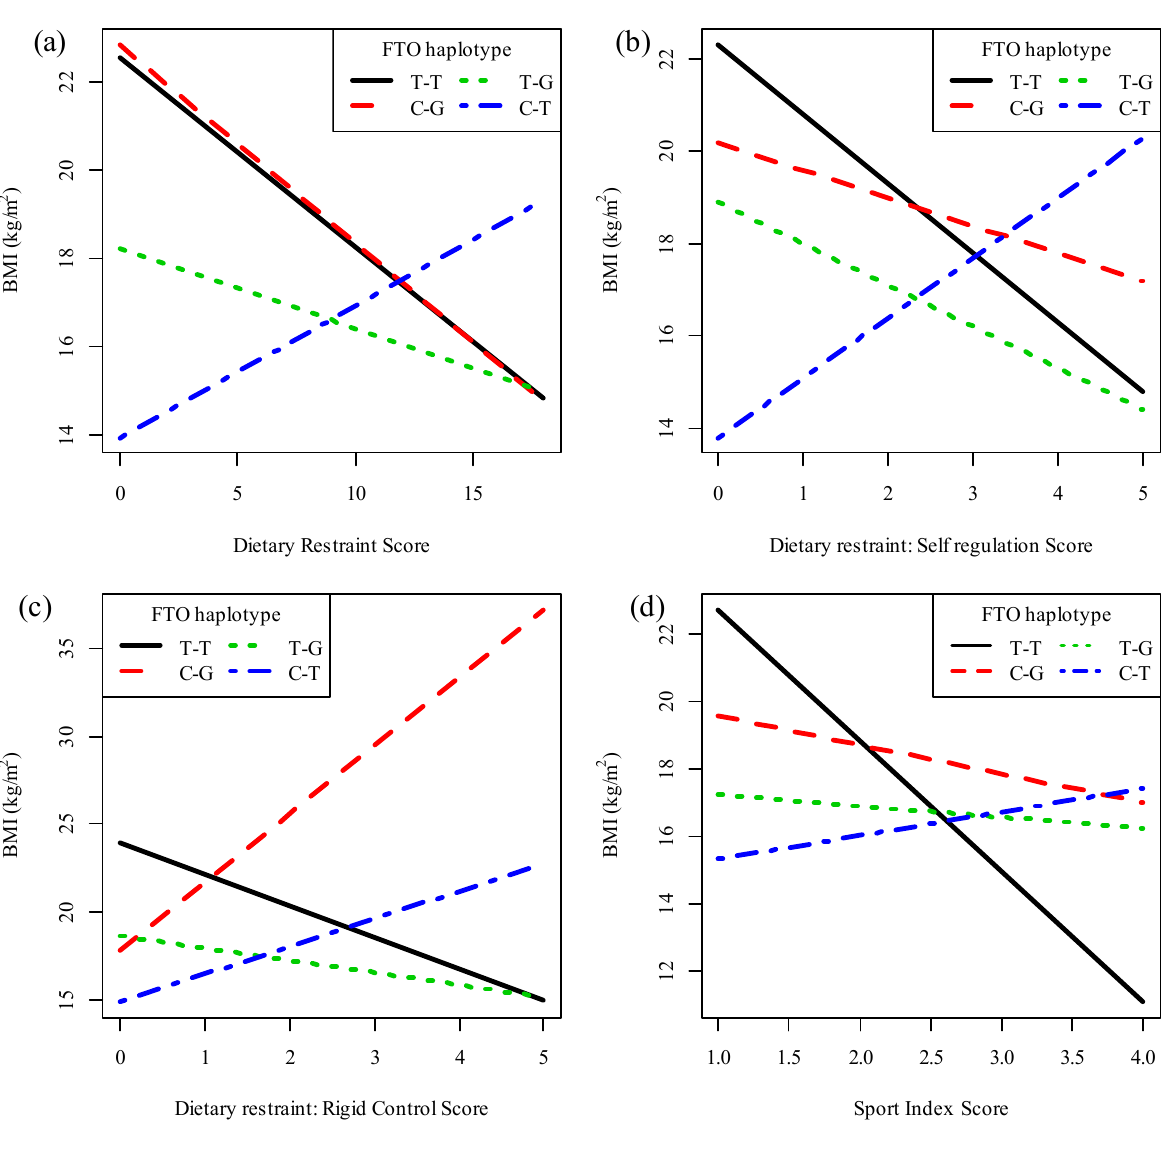
Figure 2. Interactions between the fat mass and obesity-associated ( FTO ) rs1421085- rs17817449 haplotype and eating behavior or physical activity on BMI. Plots of BMI against ( a ) dietary restraint; ( b ) self-regulation; ( c ) rigid control and ( d ) sport index scores. Regression lines show the expected relationships, for a woman, from the